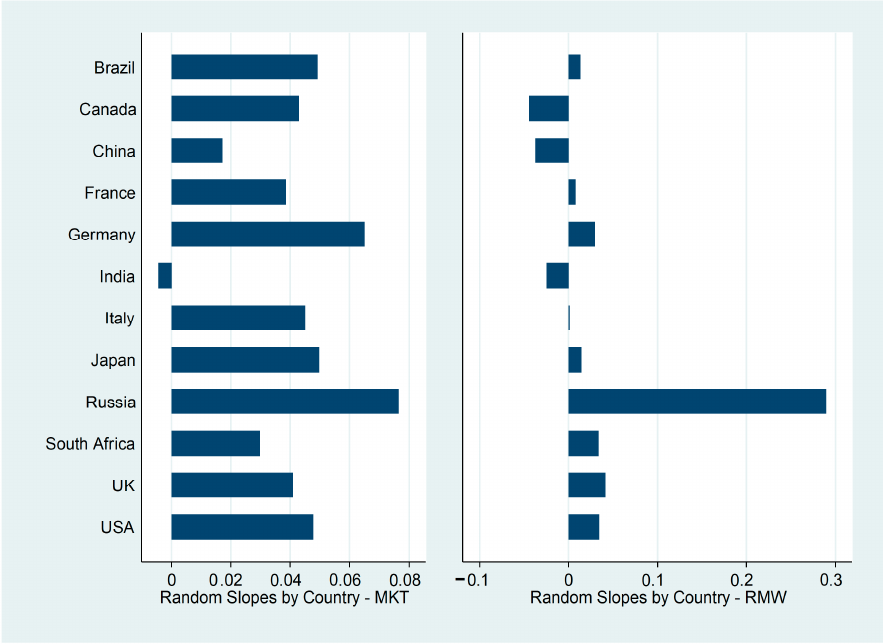
Figure 5. Expected values of random effects slopes by country estimated by the risk factors MKT and RMW for the linear trend model only with the explanatory variable YEAR in the fixed effects component.